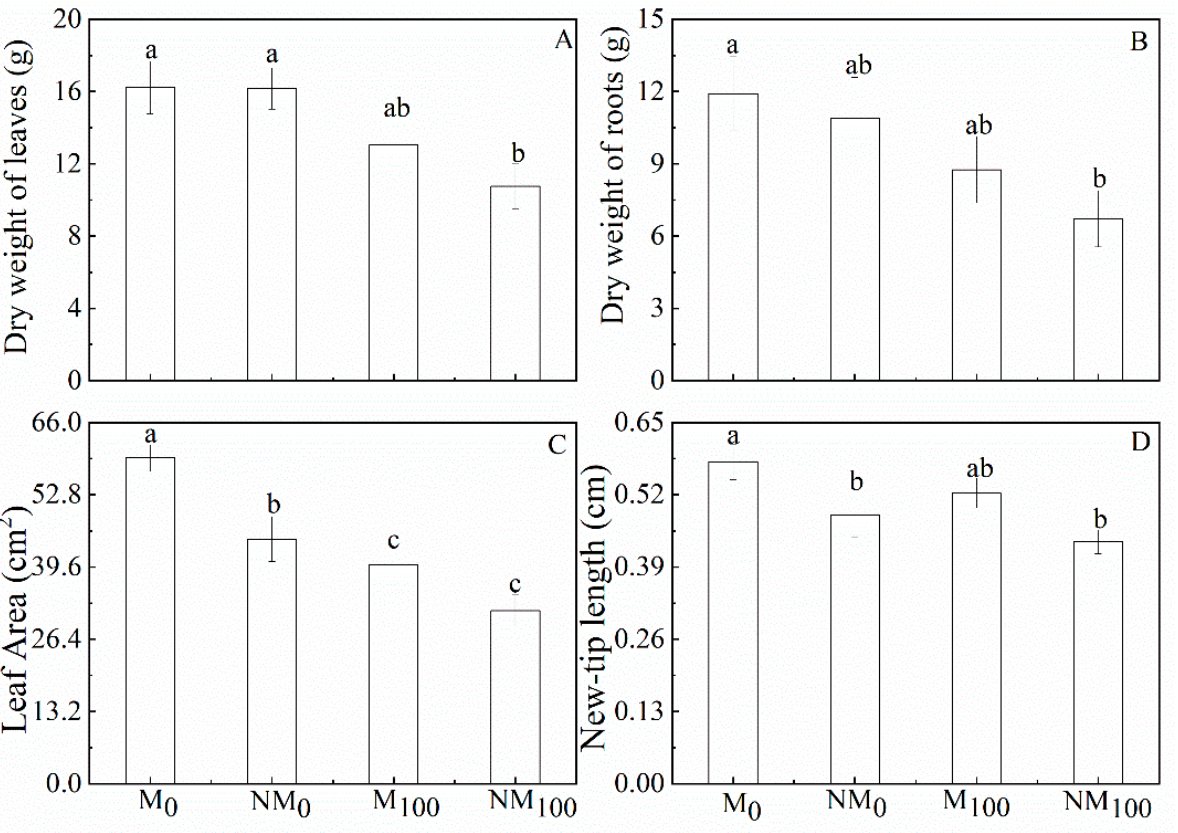
Figure 1. Changes in the biomass (dry weight) of leaves ( A ), roots ( B ), leaf area ( C ), and length of the new tip ( D ) in Neva irrigated with or without magnetized water following exposure to 0 or 100 µ mol · L − 1 cadmium stress. Values are the means ± SE of at least three replicates. Different lowercase letters indicate significant differences among the four treatments at the 0.05